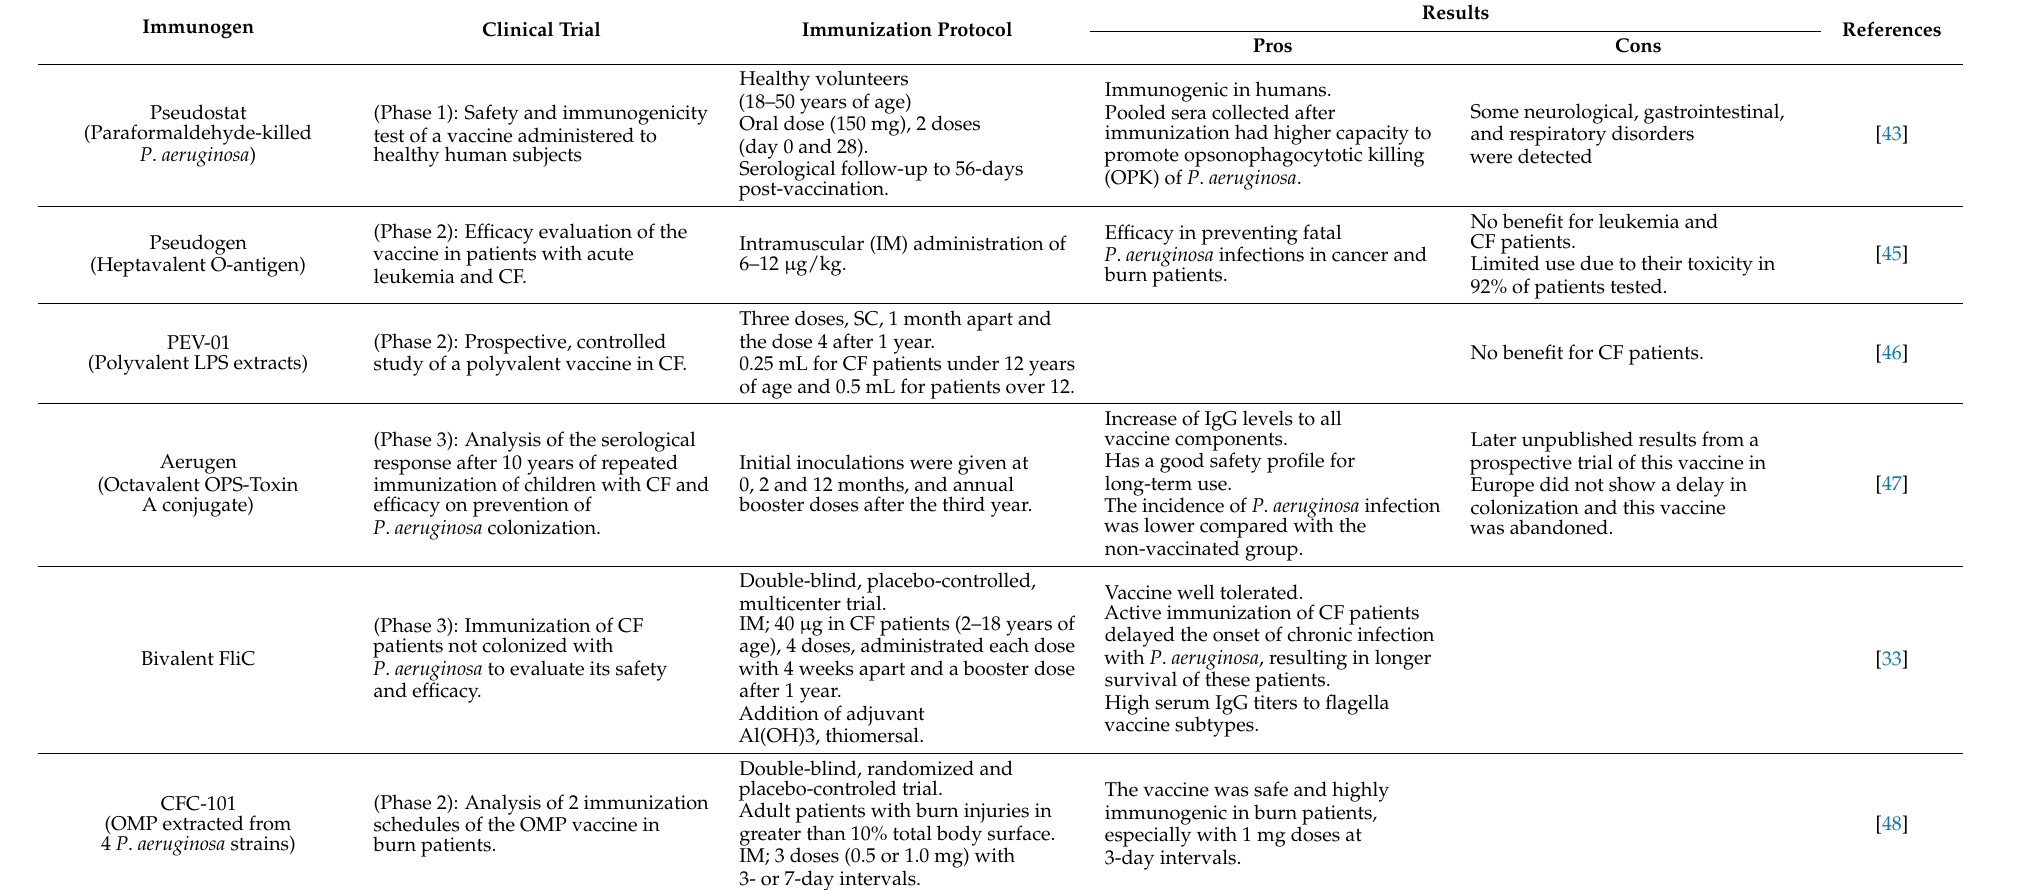
Table 1. Active immunization clinical trials against P . aeruginosa